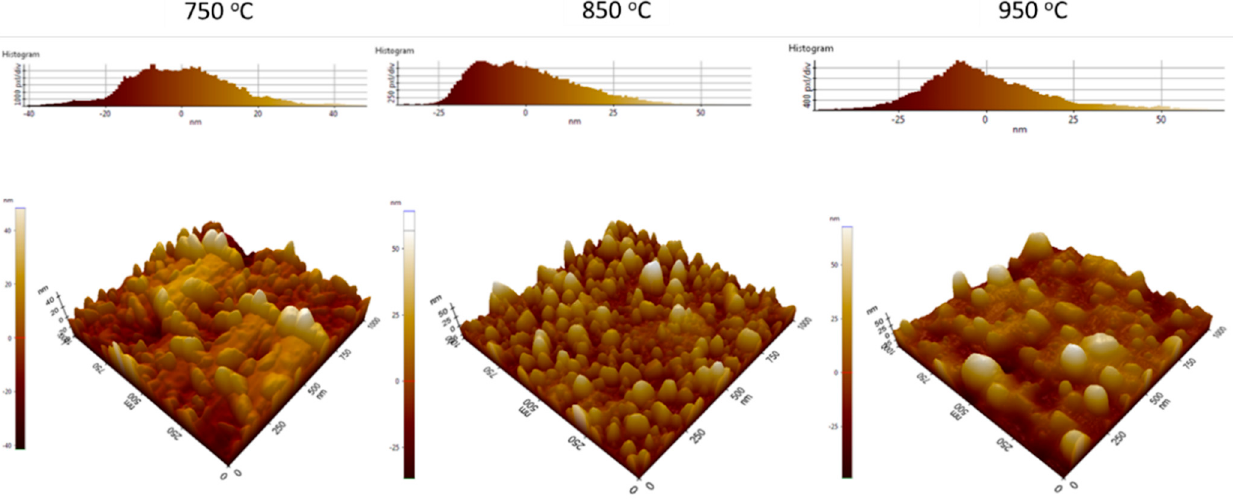
Figure 9. Distribution of particles on surface using AFM method.